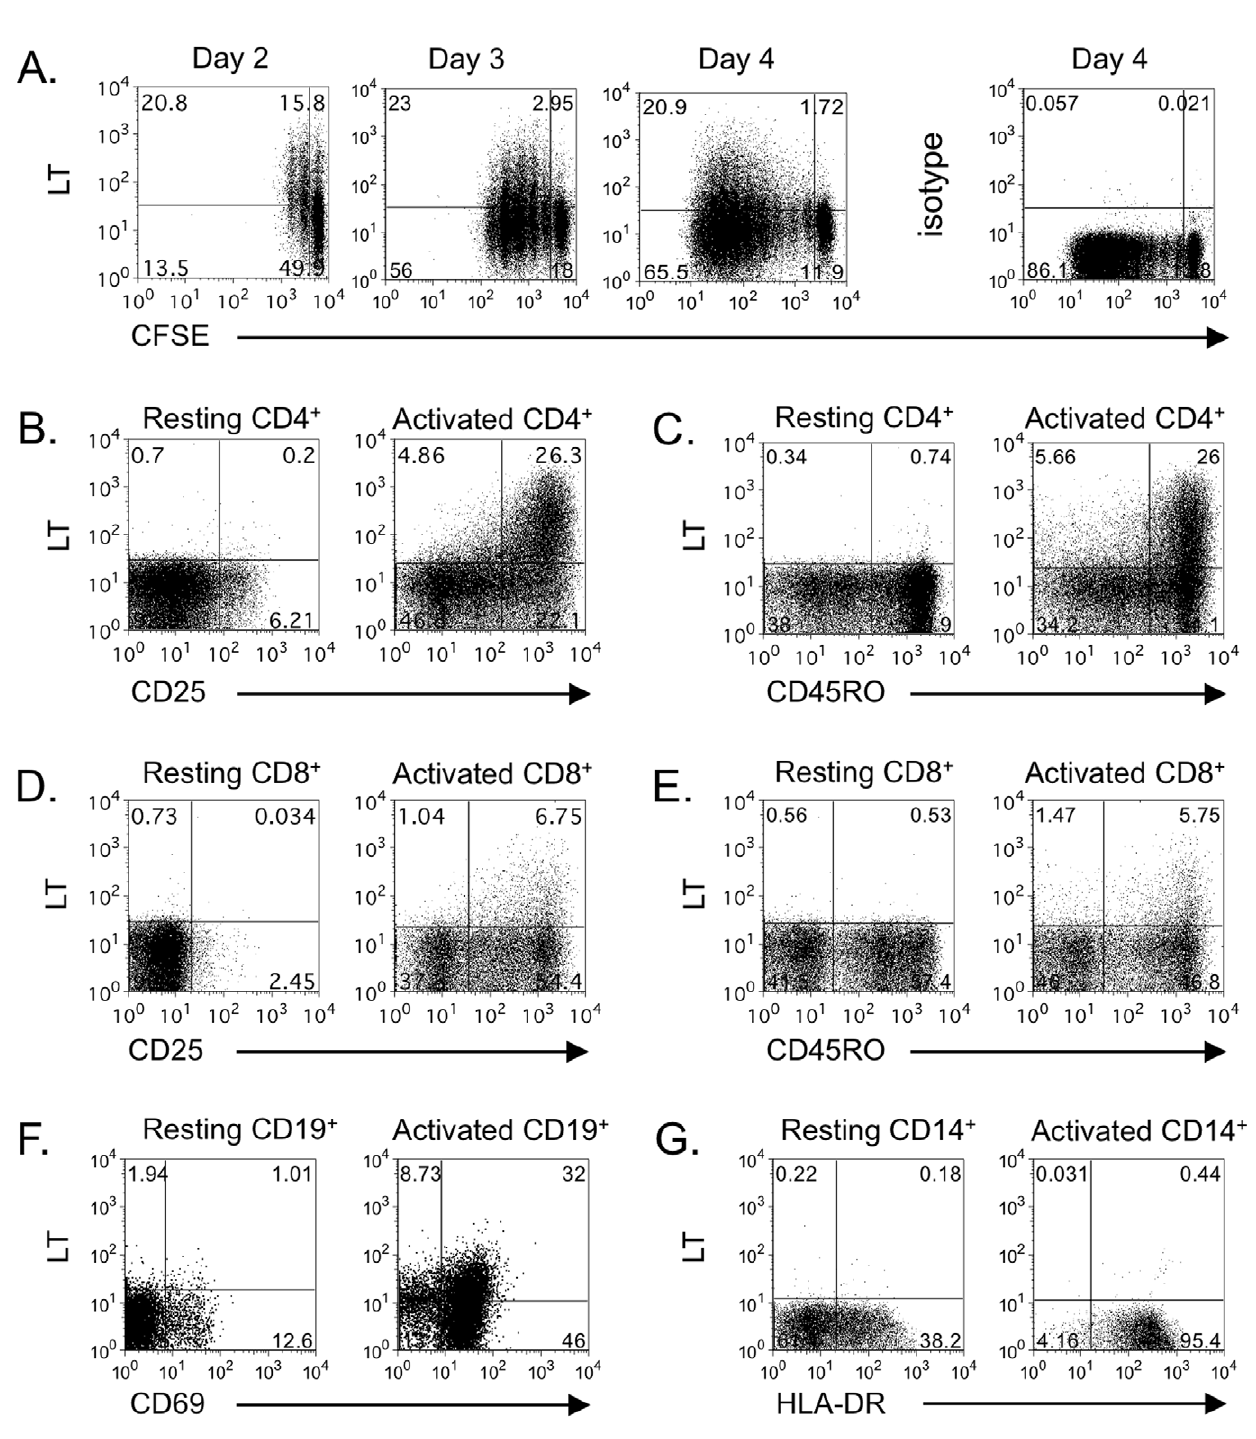
Figure 1. LT expression on human immune cell populations. Human CD4 + T cell expression of LT. A . Sorted CD4 + T cells were labeled with CFSE and proliferation and LT expression was monitored at indicated time points following stimulation with anti-CD3 and anti-CD28. B , C . Co- expression of LT with T cell activation markers CD25 ( B ) or CD45RO ( C ) on CD4 + gated cells. D , E . CD8 + T cell expression of LT. Co-expression of LT with CD25 ( D ) or CD45RO ( E ) on CD8 + gated cells. For CD4 + and CD8 + T cell activation, PBMCs were stimulated with anti-CD3 and anti-CD28 mAbs for 2 days. F . Human B cell expression of LT. B cells were stimulated with anti-IgM and BAFF for two days, then LT expression determined on CD19 + B cells with CD69 as a marker for activation. G . Human monocyte expression of LT. CD14 + monocytes were stimulated with LPS, with activation status assessed on the basis of HLA-DR up-regulation.